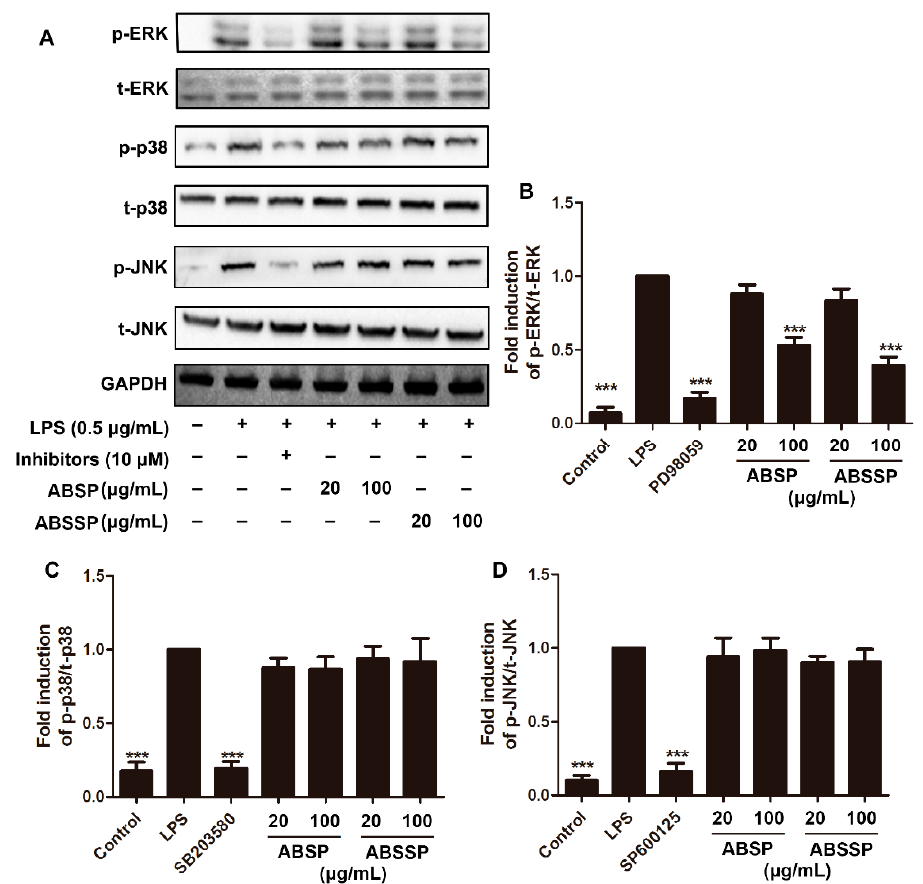
Figure 6. Effects of ABSP and ABSSP on LPS-induced activation of extracellular regulating kinase (ERK), p38 mitogen-activated protein kinase (MAPK), and c-Jun N-terminal kinase (JNK) in RAW264.7 cells. RAW264.7 cells were pretreated with different concentrations of ABSP and ABSSP or specific inhibitors (PD98059, SB203580, and SP600125; 10 μ M) for 4 h, and then exposed to LPS for an additional 30 min. Next, cell lysates were used to detect the phosphorylation levels of ERK, JNK, and p38 MAPK using specific antibodies. The nonphosphorylated MAPK proteins were used as the loading control. Results from representative experiments are shown ( A ). Quantification of the ratio of phosphorylated ERK ( B ), p38 MAPK ( C ), and JNK ( D ) normalized to the loading control. Data are expressed as mean ± SD, n = 3. * p < 0.05, ** p < 0.01, *** p < 0.001, compared with LPS.